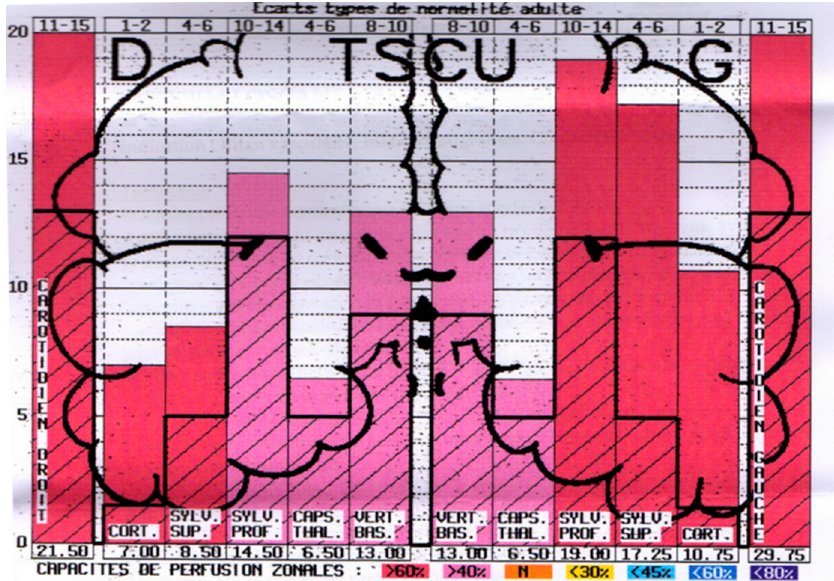
Figure 4. Example of pictogram showing the normal mean pulsometric index (MPI) values in the different regions individualized by UCTS in both temporal lobes (dark line) from the surface (cortex) to the median line of the brain wall of the third ventricle and real values of the pulsometric index (PI) for each region recorded in this particular example [3]. Note that here PI are over normal MPI in all regions.